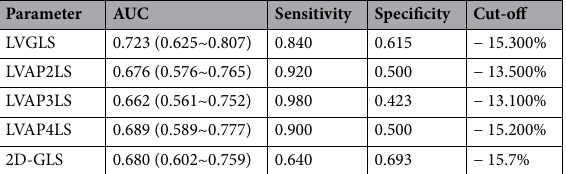
Table 6. ROC curves of aCMQ parameters and 2D-GLS predicting LV systolic dysfunction in patients with T2D.